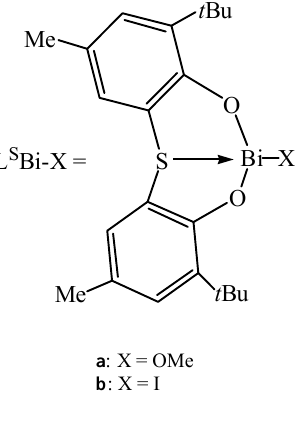
Figure 5. New bismuth compounds